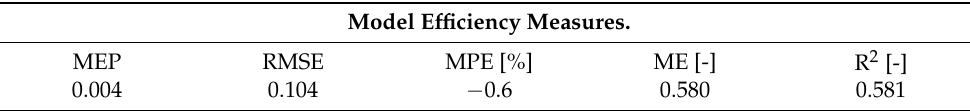
Figure 6. The measured versus simulated soil moisture ratio. Multivariate analysis (RDA) was employed to explain the relative importance of particular explanatory variables and underline differences between parameters. The patterns of the independent variables for soil factors and environmental parameters are shown on the plot (Figure 7). We noted a positive correlation among the flow direction, slope, clay content and wetness coefficient. Generally, multivariate analysis for the studied parameters indicated a strong positive correlation among the soil hydrologic